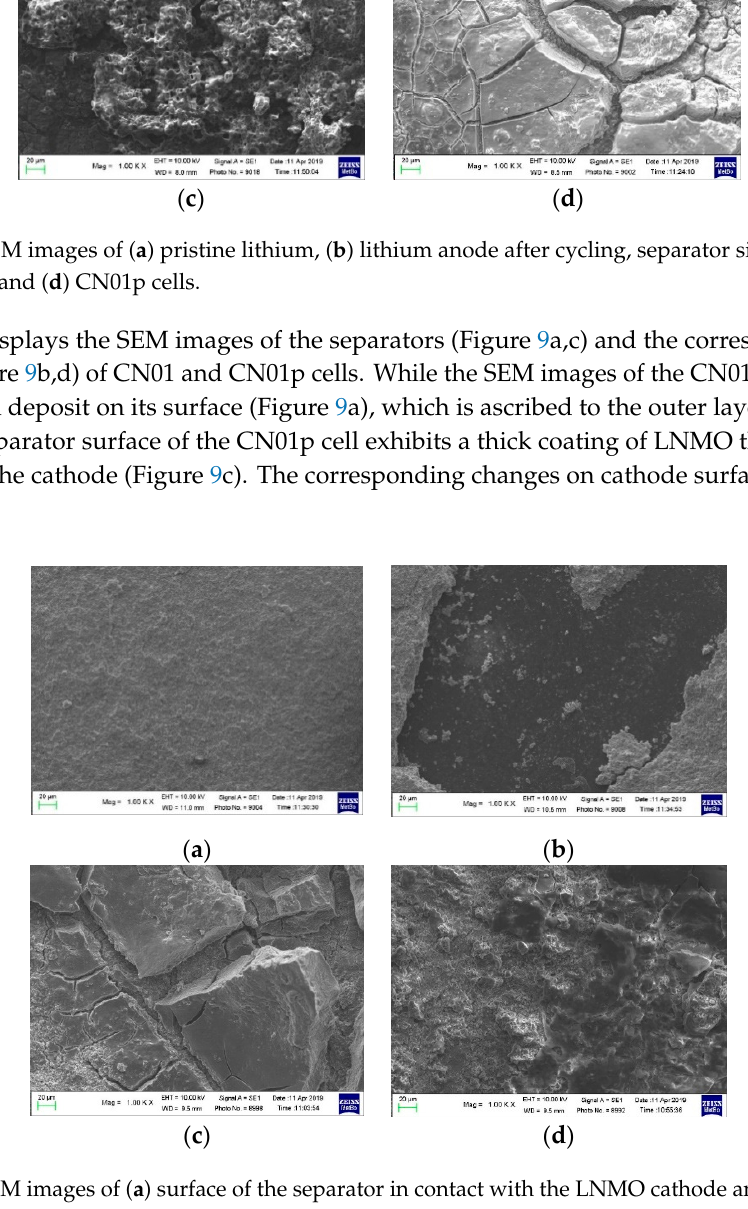
Figure 9. SEM images of ( a ) surface of the separator in contact with the LNMO cathode and ( b ) LNMO cathode in CN01 cell; ( c ) surface of the separator in contact with the LNMO cathode and ( d ) LNMO cathode in CN01p cell.